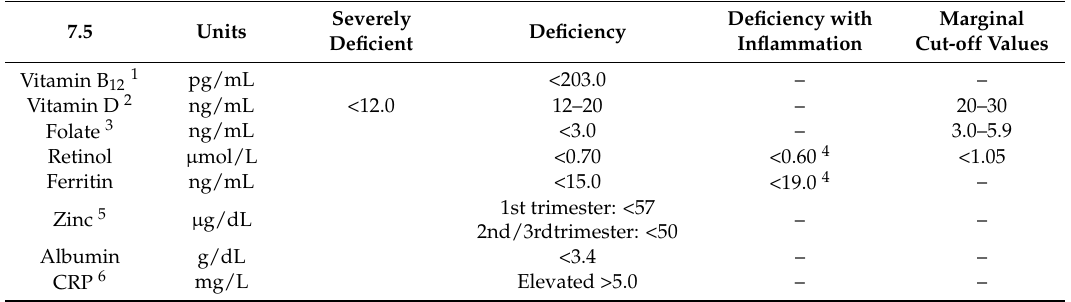
Table 2. Deficiency and marginal status cut-off values for pregnancy and inflammatory